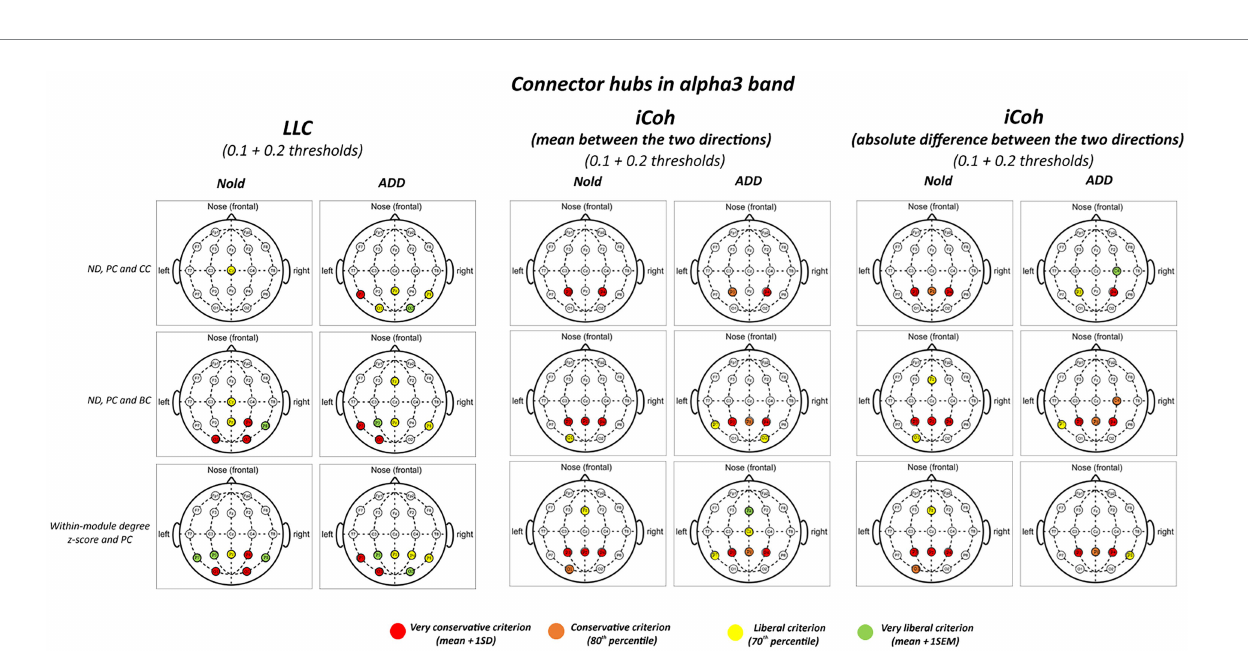
FIGURE 4 Connector and provincial hubs for the alpha 3 linear lagged connectivity (LLC, left column), mean (middle column), and absolute difference isolated lagged effective coherence (iCoh, right column) values in the Nold and ADD groups defined according to the three approaches used in the present study. Upper row: hubs were defined according to nodal degree (ND) and classified into connector and provincial hubs according to the participation coefficient (PC) and clustering coefficient (CC) calculated at 0.1 and 0.2 graph thresholds, in line with the approach described by Franciotti and Bonanni. Middle row: hubs were defined according to nodal degree (ND) and classified in connector and provincial hubs according to the participation coefficient (PC) and betweenness centrality (BC) calculated at 0.1 and 0.2 graph thresholds, in line the approach described by Cole et al. (2015). Lower row: hubs were defined according to the within-module degree z-score and classified into connector and provincial hubs according to the participation coefficient (PC) calculated at 0.1 and 0.2 graph thresholds, in line with the approach described by Power et al. (2013). Colors correspond to the different criteria adopted (mean and SD, 80th/20th percentile, 70th/30th percentile, mean and